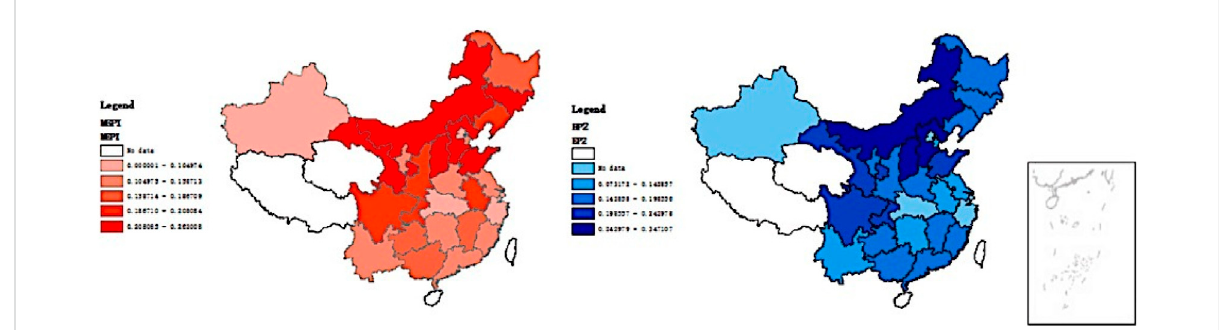
FIGURE 1 Spatial distribution of energy poverty indices MEPI and